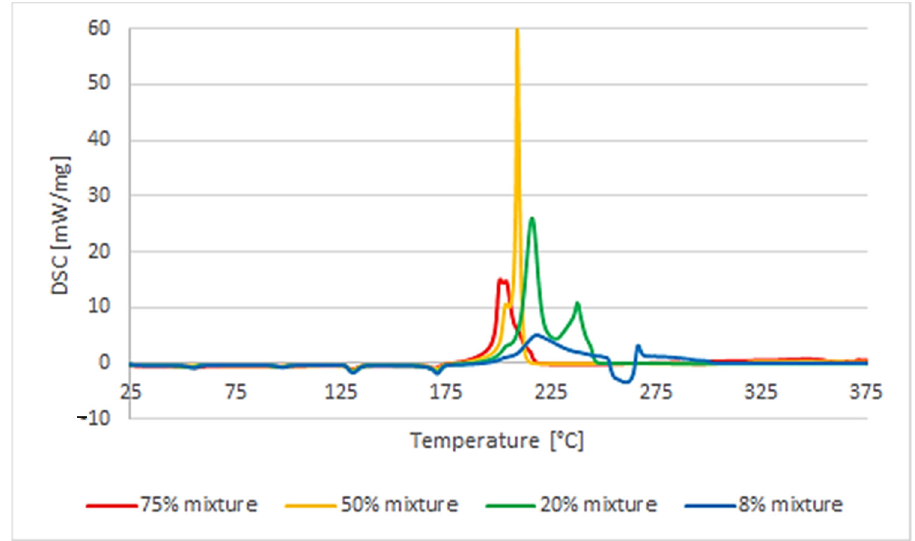
Figure 11. DSC analysis of AN and PA mixture composition influence on their thermal properties, heat rate 10 °C/min.